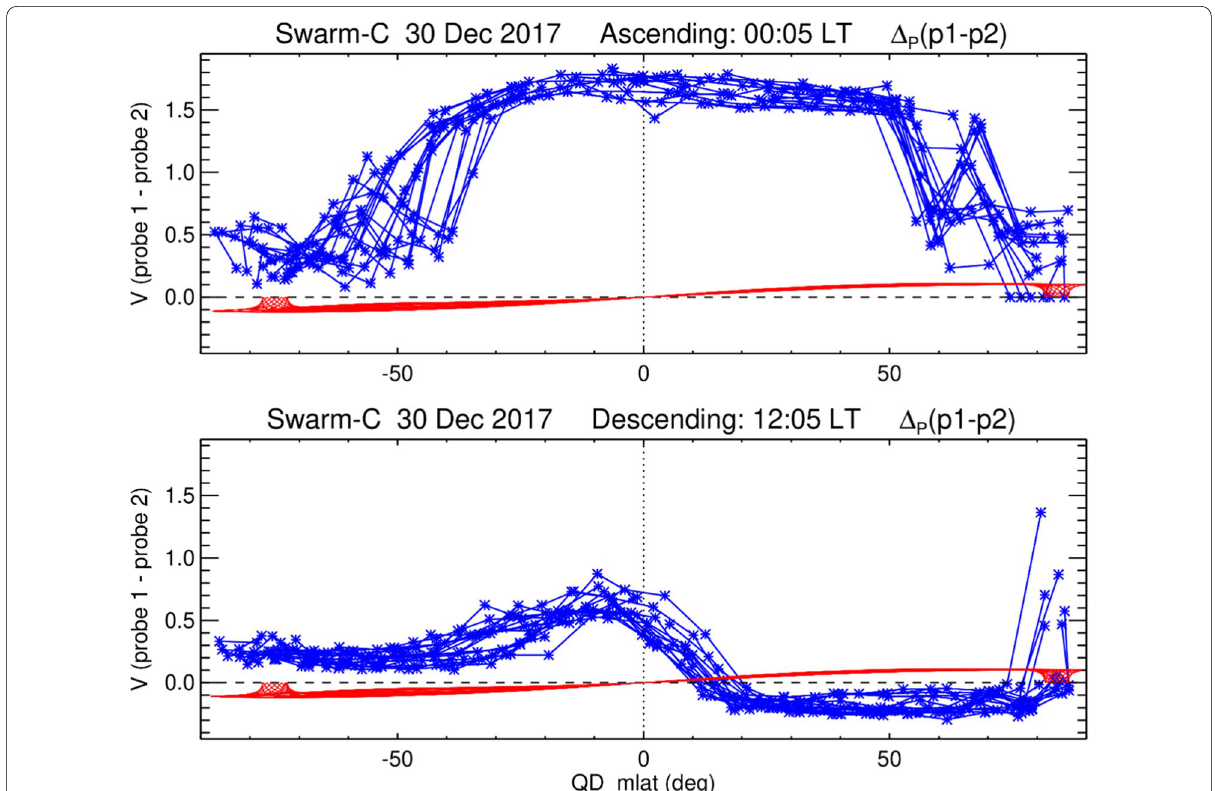
Fig. 11 Example of the difference of floating potential estimates between Langmuir probes 1 and 2 (blue) as a function of QD_Mlat, for nightside (ascending, top) and dayside orbits (descending, bottom). The red plot shows the theoretical inter-probe potential variation which may be expected as a result of electro-magnetic forces created by the spacecraft’s